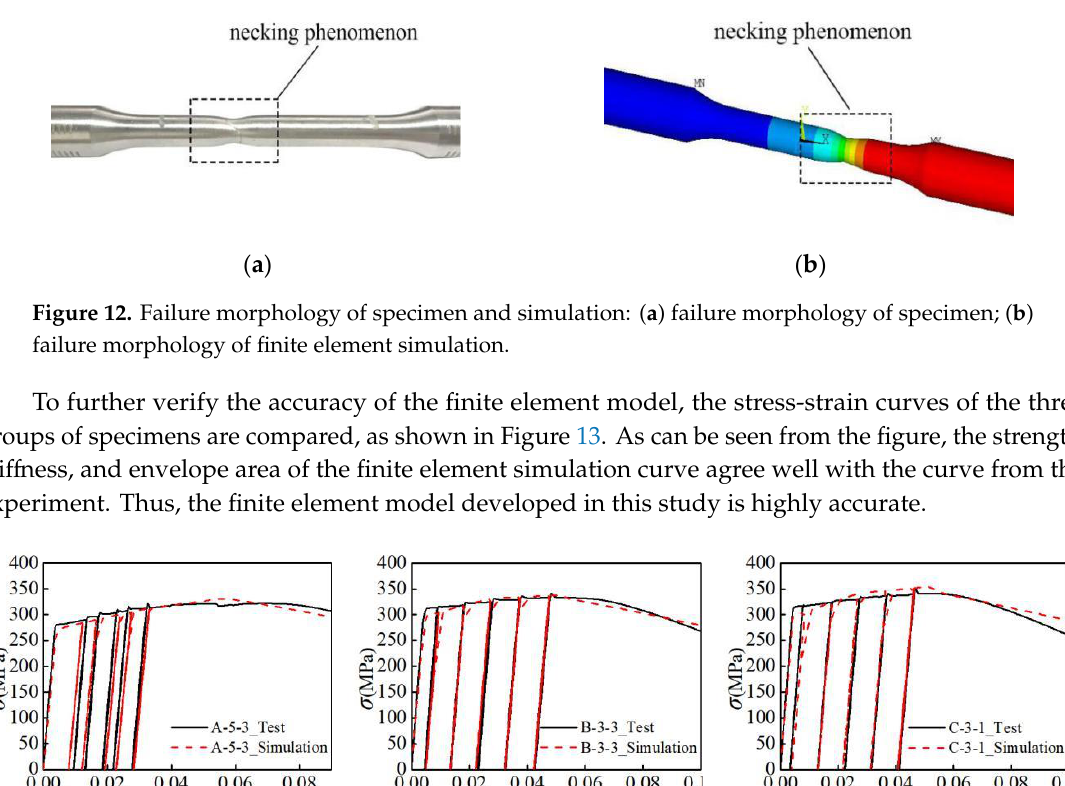
Figure 11. Stress-strain curve of aluminum alloy.